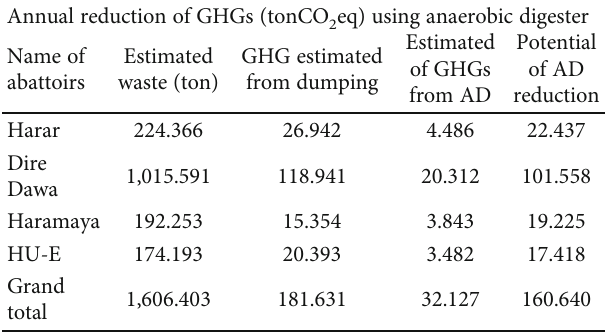
Table 4: Estimation of potential reduction of GHG emission using anaerobic digester per